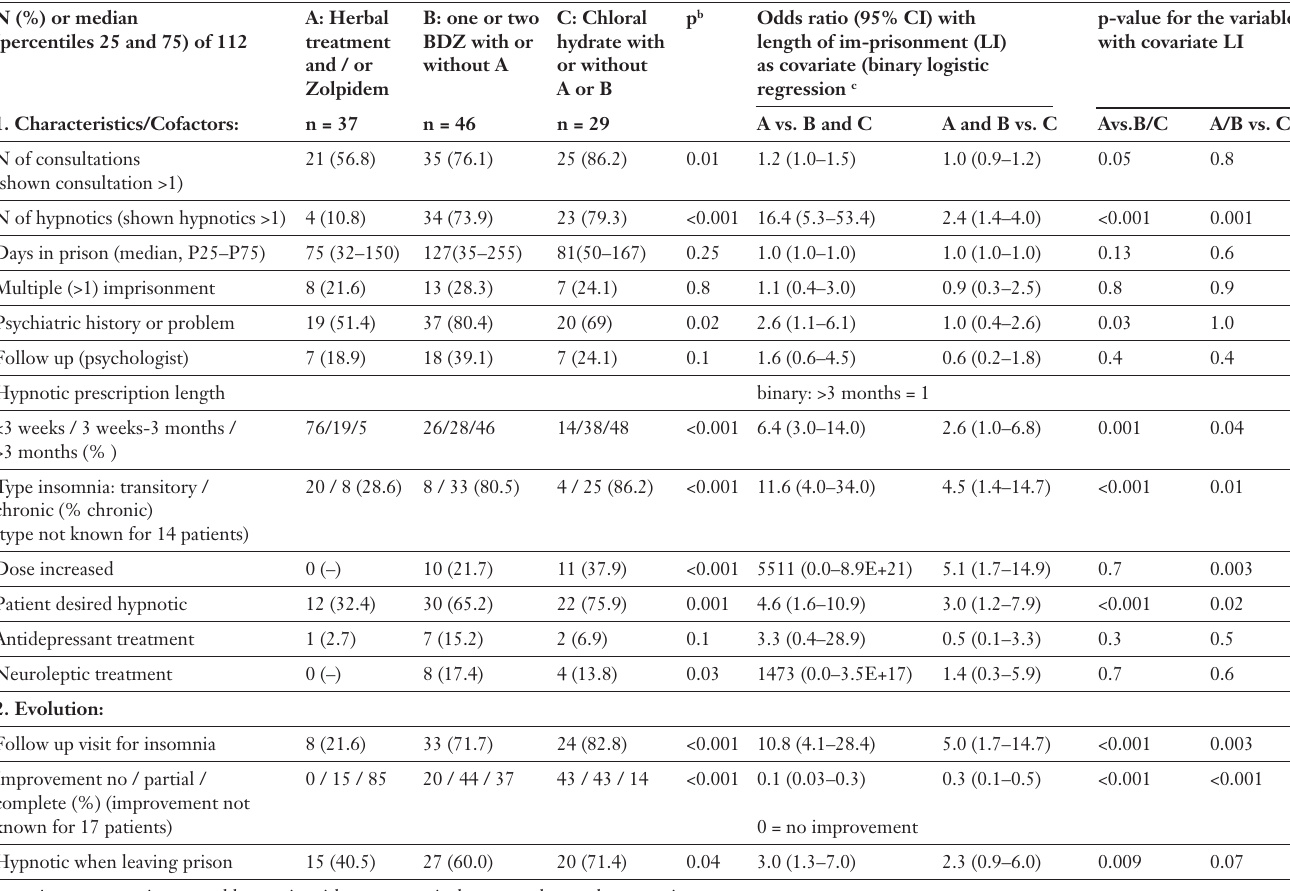
Table 2b Comparison of characteristics, cofactors and evolution of patients receiving a particular type of hypnotic a among the 112 non-substance-misusing insomnia patients